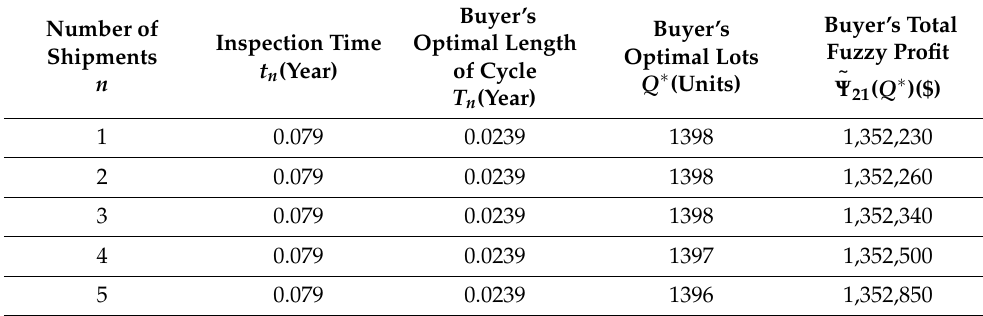
Table 5. Effect of shipment on lot, inspection time and buyer’s profit.